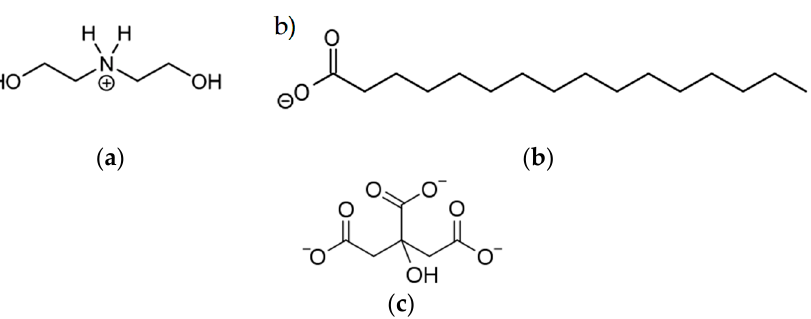
Figure 1. ( a ) Bis(2-hydroxyethyl)ammonium cation; ( b ) Palmitate anion; ( c ) Citrate